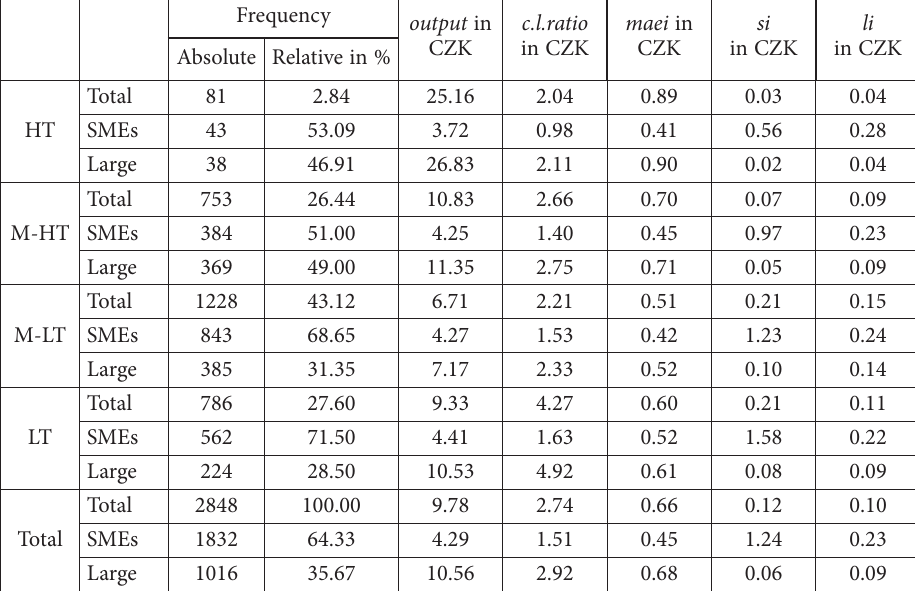
Table 2. Primary data by technological intensity and by size (source: authors’